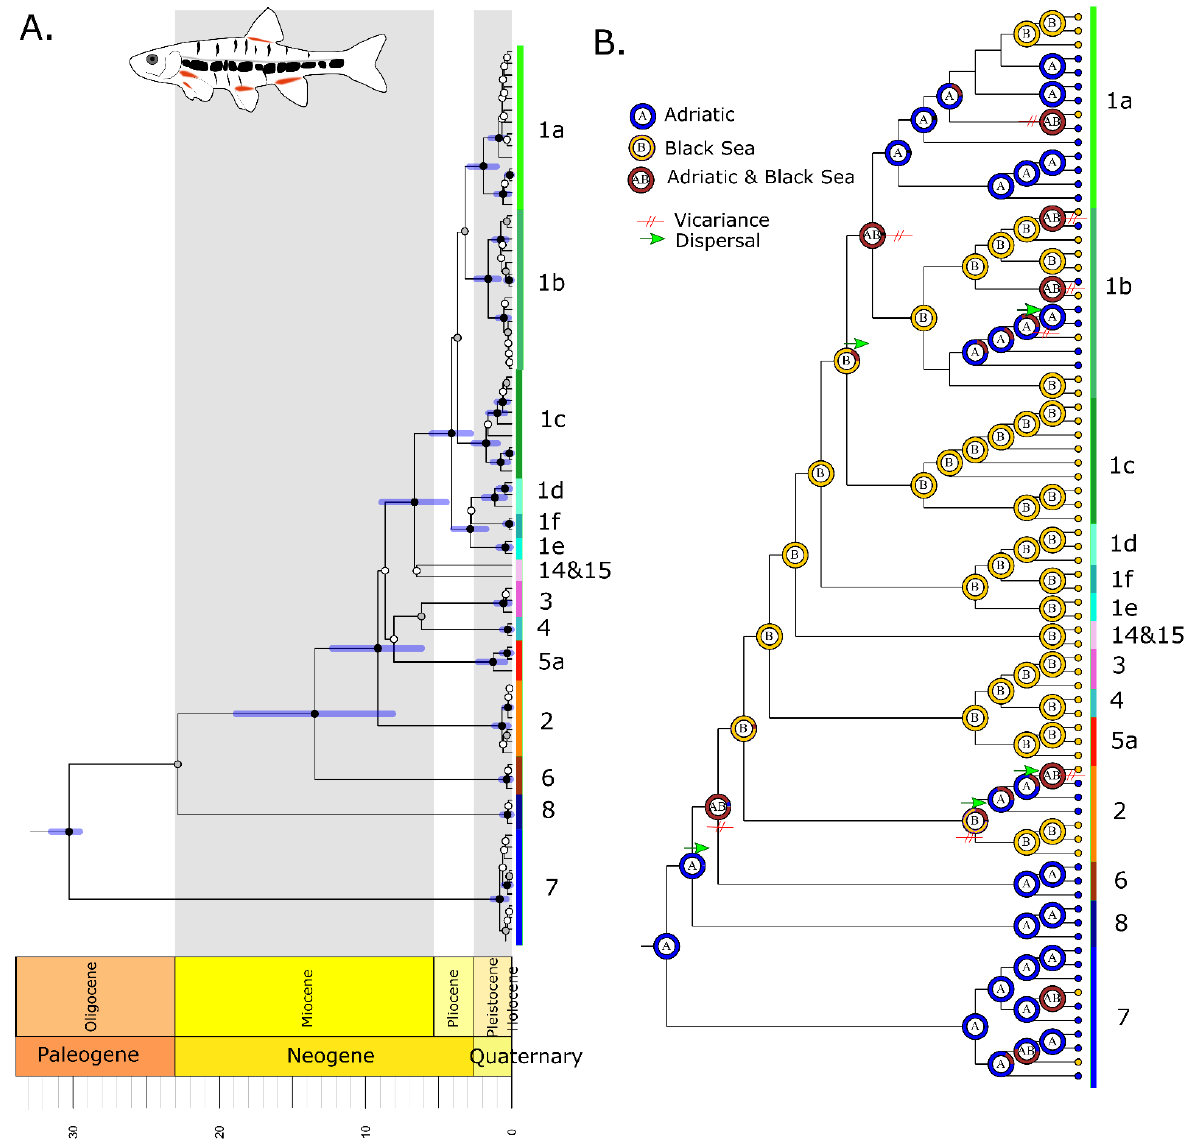
Figure 4. Divergence time estimates and reconstruction of ancestral areas (RASP) analyses of Balkan Phoxinus based on the cytochrome b fragment. ( A ) Divergence time estimates, calculated in BEAST [77], between mt lineages 1(a –f) and 8, 14 and 15, encoded following Palandačić et al. [ 37]. Time of splitting is represented by horizontal bars corresponding to a 95% HPD interval. Posterior probabilities (pp) = ≥0.95 are indicated as black dots, pp = <0.95 and ≥0.75 are grey and pp = <0.75 are white. The scale represents millions of years. ( B ) Results from reconstruction of ancestral areas based on two defined biogeographic areas: Adriatic and the Black Sea basins. The analysis was performed with S-DIVA [62] and implemented in RASP [85] based on the phylogenetic trees calculated in 4A. Pie charts at nodes represent the most likely ancestral distributions and letters denote the regions (Adriatic, Black Sea or both) encoded by the respective color. Colors of tip labels indicate the current distribution of each tip. Only ancestral areas with a probability of >0.5 are shown. Vicariance or dispersal events, or both, are given next to the pie chart. Only the topology is shown. For better visualization, outgroups are not shown.